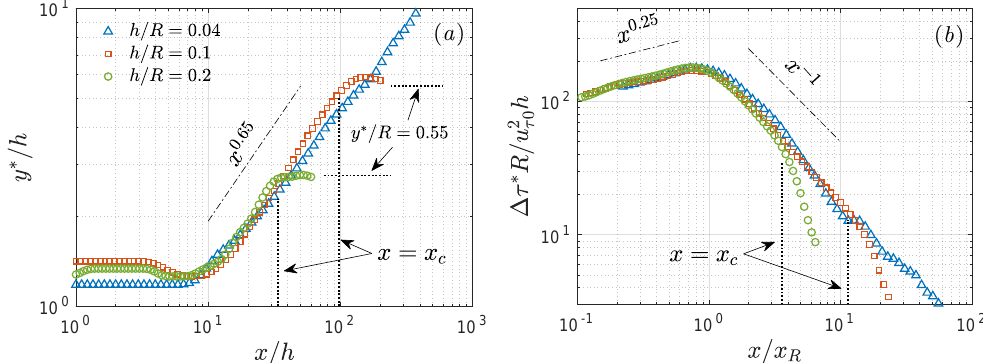
Figure 8. Development of ( a ) the wall-normal location of maximum shear stress, y ∗ , and ( b ) the maximum shear stress in a given profile, ∆ τ ∗ . y ∗ and ∆ τ ∗ are plotted against their respective near-field scaling, x / h and x / x R